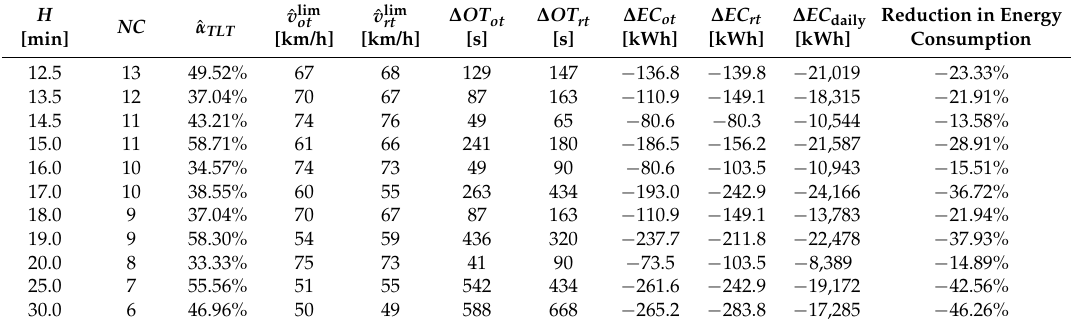
Table 5. Energy saving optimization in the case of 90th percentile.